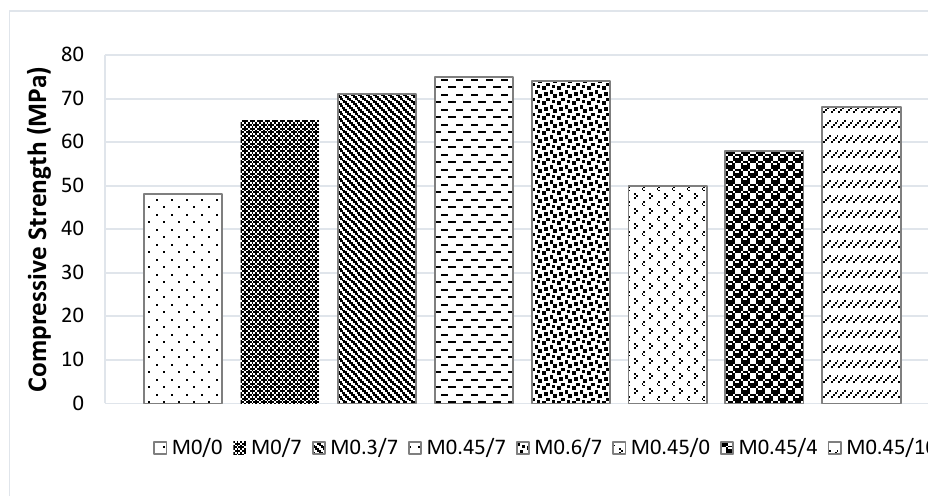
Figure 2. Compressive strength for all concrete specimens under ambient conditions.